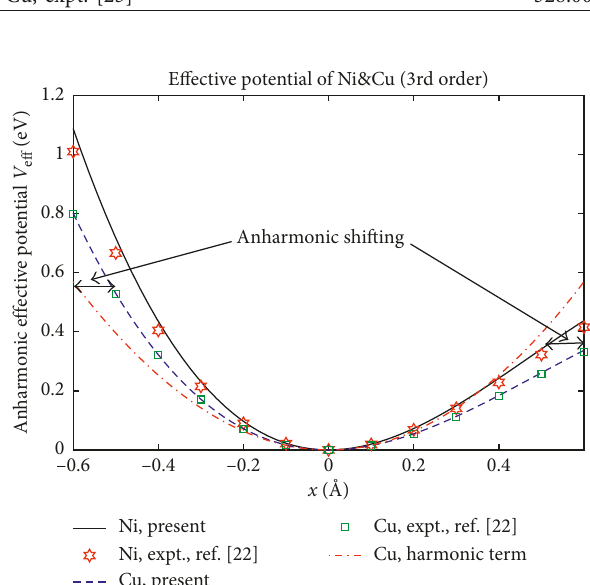
Figure 1: Anharmonic interatomic effective potentials V and Ni calculated using the present theory compared to the ex- perimental values (Expt.) [23] and to its harmonic term to show its anharmonic shifting.